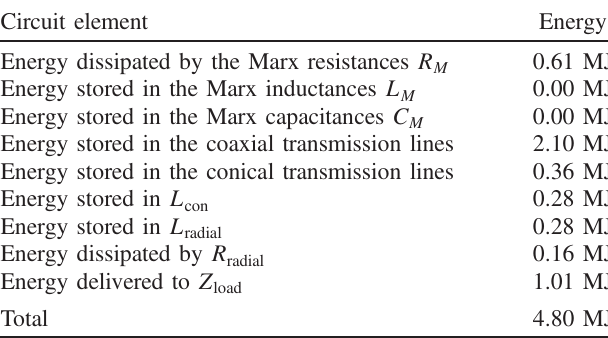
TABLE II. Energy accounting at peak load current for a Neptune shot that delivers a 380-ns linear-ramp current pulse efficiency of the coupled accelerator-load system at peak